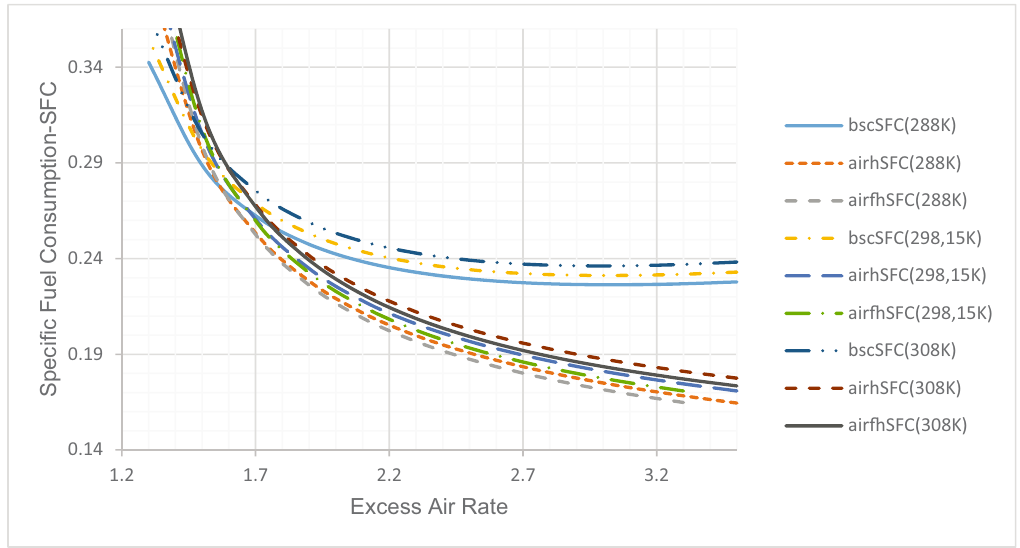
Figure 16: Variation of speci fi c fuel consumption with excess air coe ffi cient at di ff erent compressor inlet air temperatures for basic ( bsc ) , absorption cooling ( ab ) , air ( airh ) , and air fuel ( airfh ) heating cogeneration cycles ( m fuel = 1.64 kg/h, η isC = η isT = 0.86, r = 10, T recout = 850 K, T = 485.57 K, and T = 426 K ) steam Exh